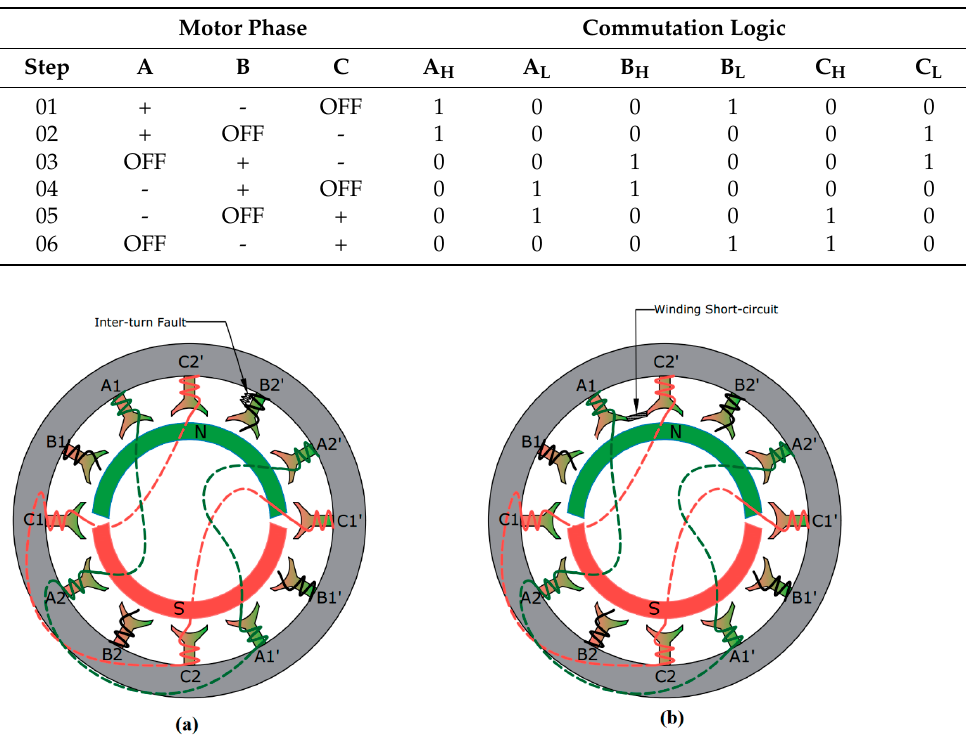
Figure 6. ( a ) Inter-turn short circuit fault. ( b ) Winding short-circuit fault. Table 2. Commutation of BLDC